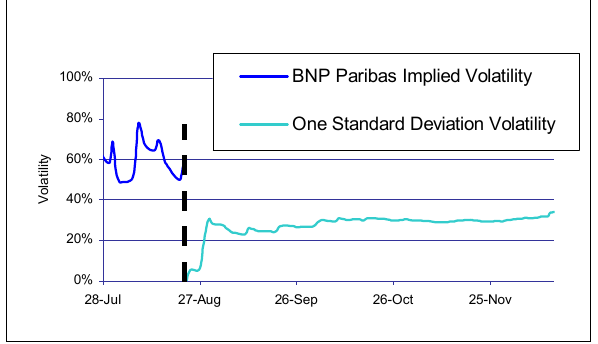
Figure 1: AngloPlat: Implied vs Historical Volatility Empirical analysis